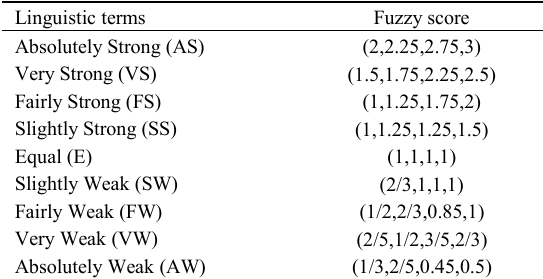
Table 1. Fuzzy evaluation scores for the weight